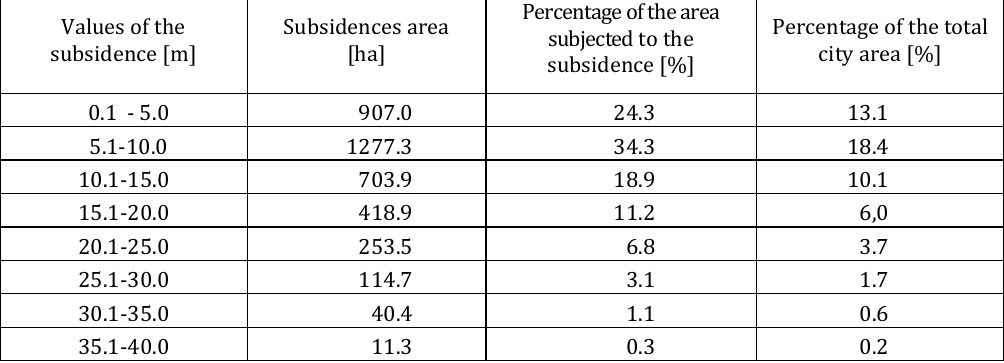
Table 1. Surface percentage of the Bytom area of the determined subsidence value (the author’s own work) Values of